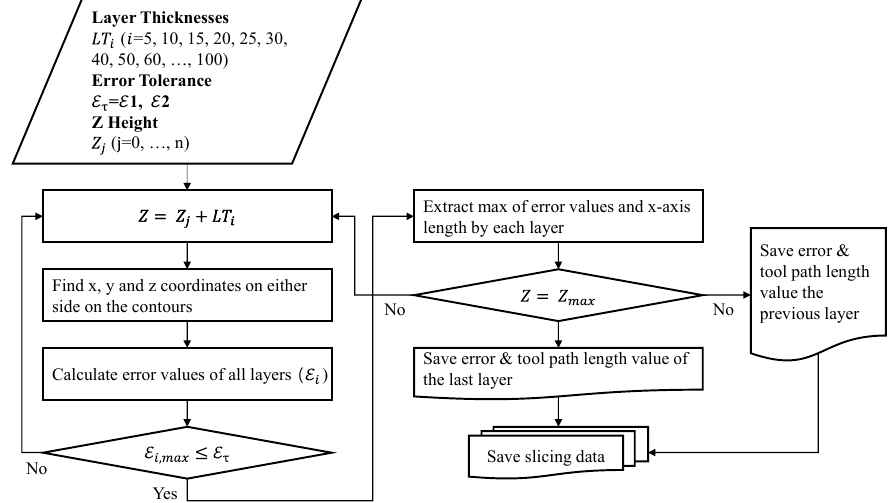
Figure 3. Determination process of layer thickness in the adaptive slicing.